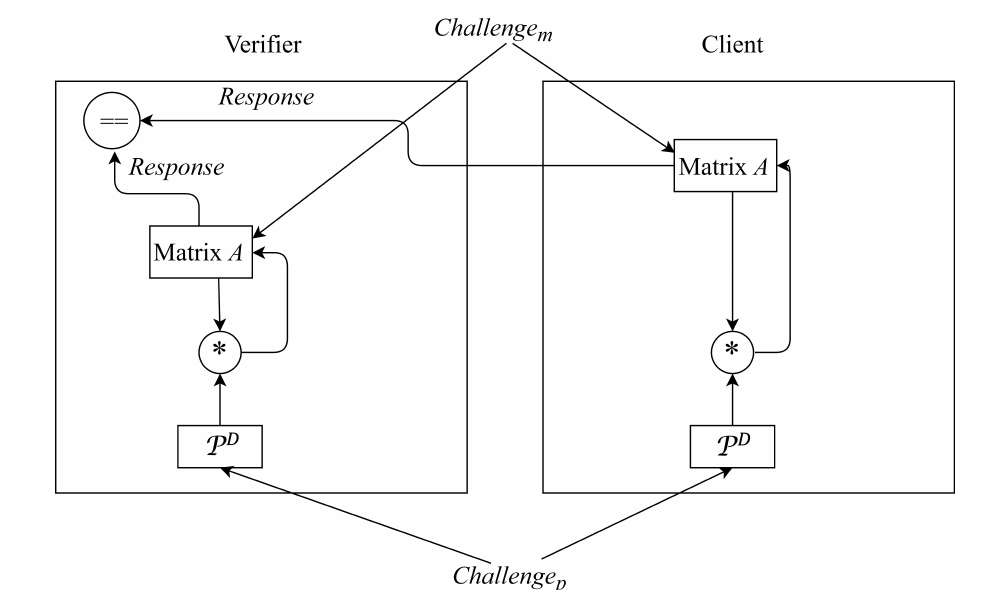
Figure 8. Flow chart of authentication model based on matrix